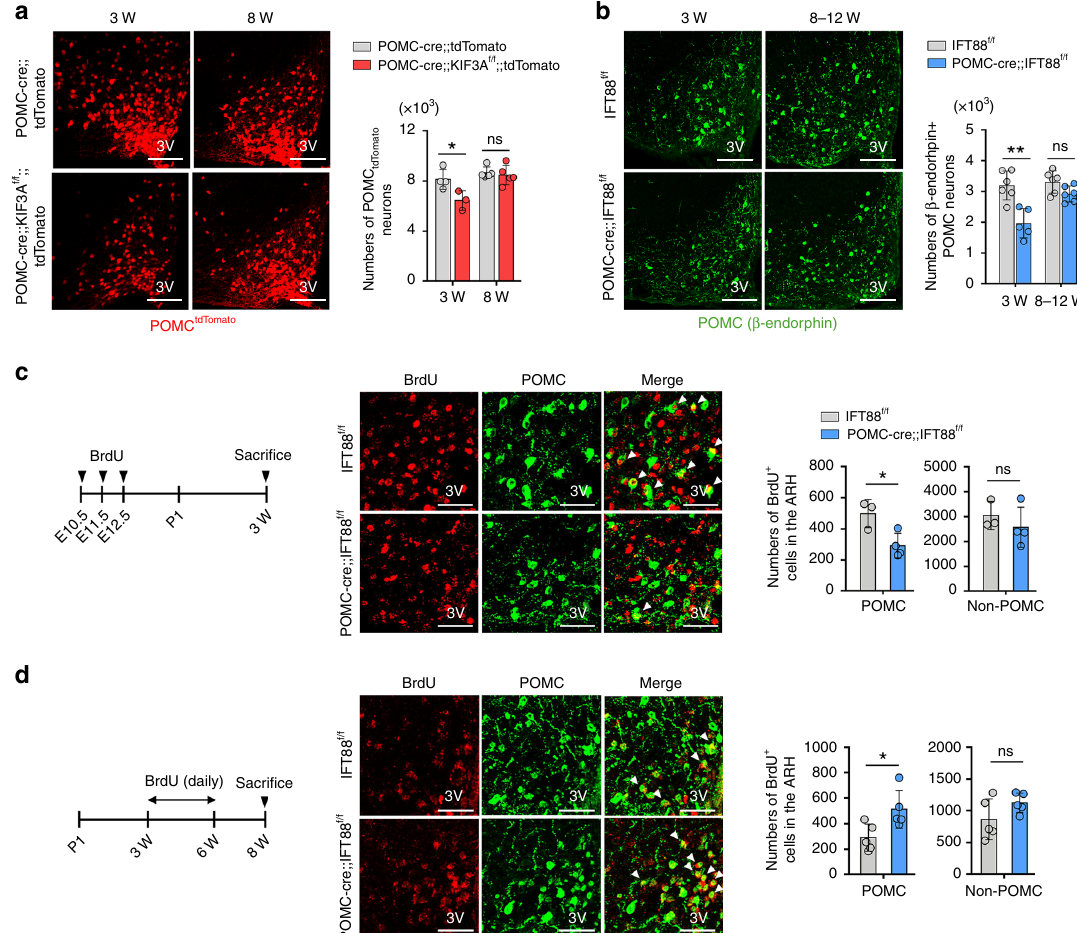
Fig. 4 Altered neurogenesis in the developing POMC neurons with ciliary dysgenesis. a The numbers of tdTomato-labeled POMC neurons in the ARH of POMC-cre;;KIF3A f/f ;;tdTomato mice compared with POMC-cre;;tdTomato littermates ( n = 5 for POMC-cre;;IFT88 f/f mice at both ages, n = 4 for IFT88 f/f mice at 3 weeks, n = 3 for IFT88 f/f mice at 8 weeks). Measurements were conducted at the indicated ages. * p = 0.0367. Scale bars: 100 μ m. 3V third cerebroventricle. b The numbers of β -endorphin-expressing POMC neurons in the ARH of POMC-cre;;IFT88 f/f mice and IFT88 f/f littermates at the indicated ages ( n = 5 for POMC-cre;;IFT88 f/f mice and n = 6 for IFT88 f/f mice). ** p = 0.002. Scale bars: 50 μ m. c 5-Bromouridine (BrdU) and POMC ( β -endorphin) double staining showing the reduced POMC neurogenesis during E10.5 – E12.5 in POMC-cre;;IFT88 f/f mice ( n = 4 for POMC-cre;;IFT88 f/f mice, n = 3 for IFT88 f/f mice). The experimental schedule was presented. Arrowheads indicate BrdU + POMC neurons. * p = 0.023. Scale bars: 50 μ m. d BrdU/ β -endorphin double staining showing the increased neurogenesis of POMC neurons in POMC-cre;;IFT88 f/f mice during the post-weaning period (3 – 6 weeks) ( n = 5). Arrowheads indicate BrdU + POMC neurons. * p = 0.027. Scale bars: 50 μ m. Data are presented as the mean ± SEM values. Statistics were performed using two-sided Student ’ s t test ( a – d ). ns not signi fi